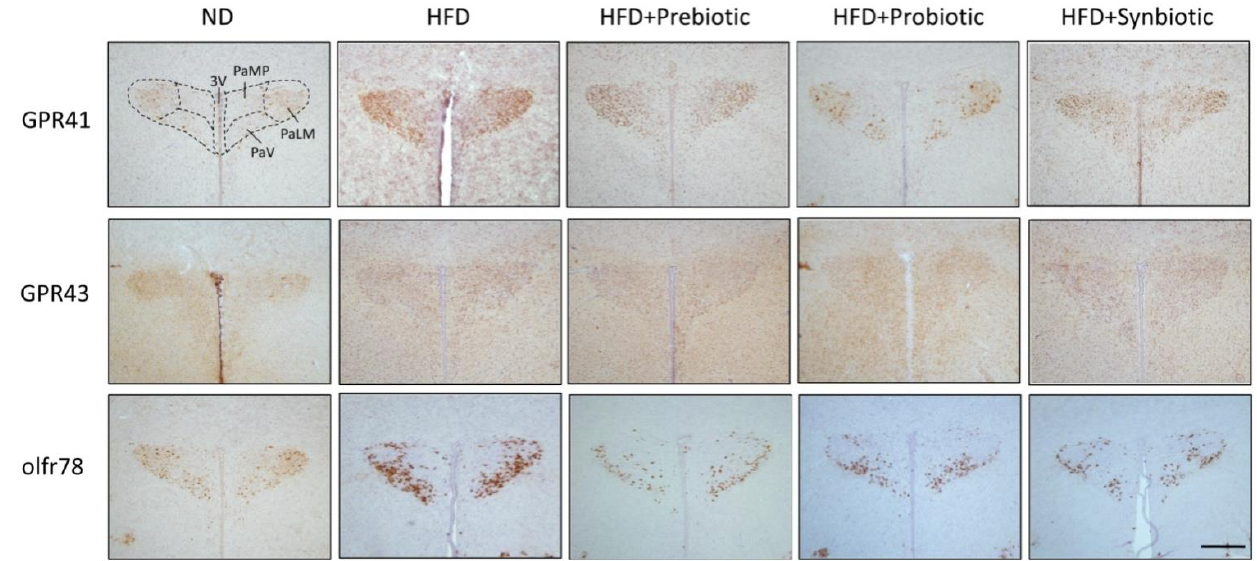
Figure 5. Representative photomicrographs showing the distribution of GPR41-, GRP43- or olfr78-immunoreactive cells (brown color) in the PVN of adult ND or HFD offspring, alone or with additional oral supplementation of FOS (4 g/kg/day, probiotic), L. gasseri (3 × 10 6 CFU/mL/day, probiotic) or FOS+ L. gasseri (synbiotic) was initiated at the age of 6 weeks. 3V, third ventricle; PaMP, paraventricular nucleus, median pavicellularis; PaLM, paraventricular nucleus, lateral magnocellularis; PaV, paraventricular nucleus, ventrolaris. Scale bar: 500 μ m.